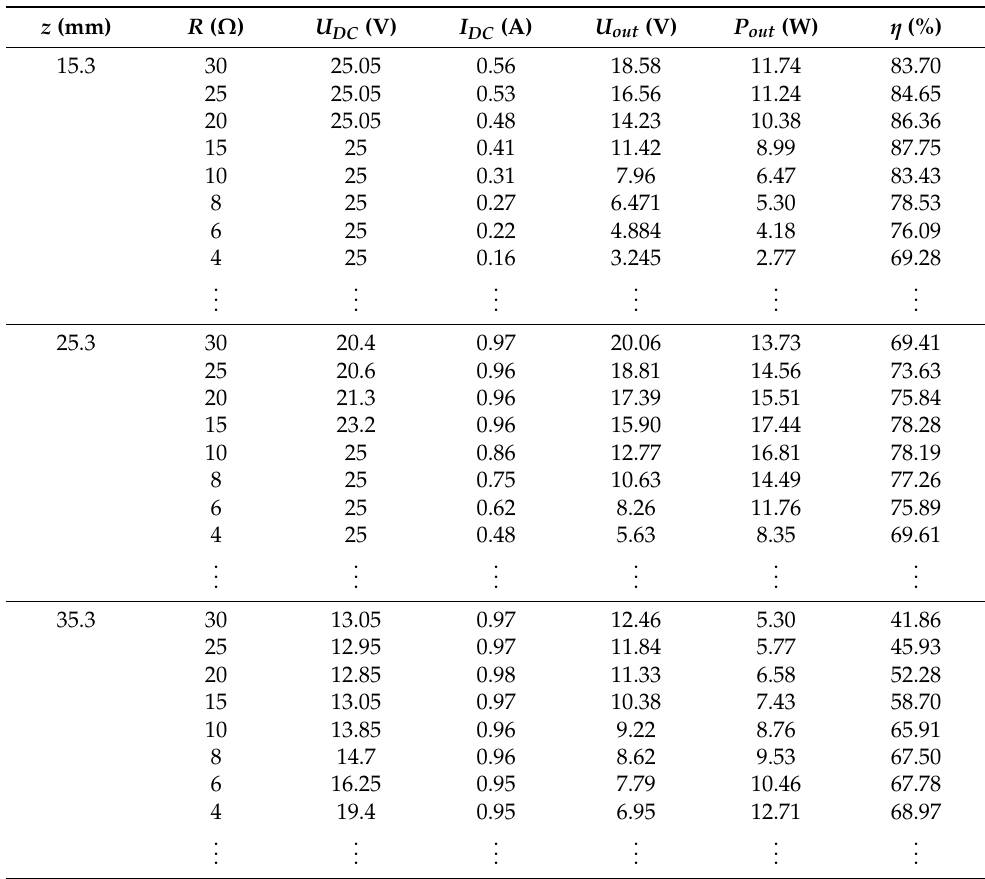
Figure 23. Impact of load variation on the IPT with the double DD coil structure: ( a ) efficiency of the system; ( b ) output power transfer. Table 8. Single DD IPT system at different